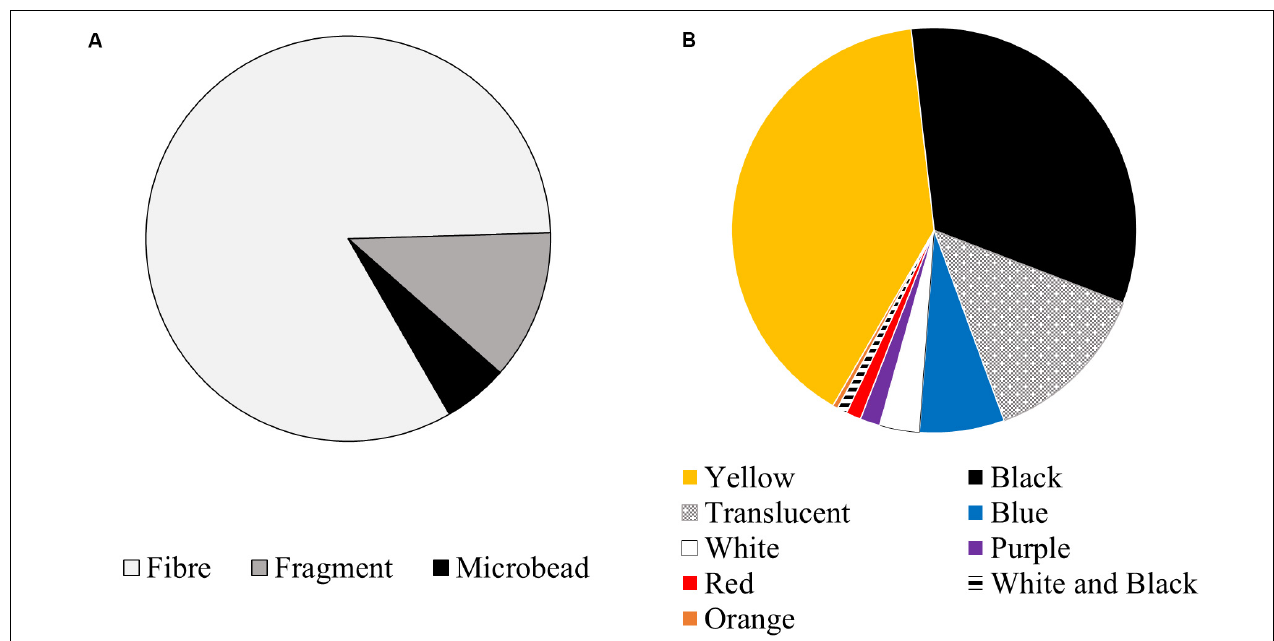
FIGURE 3 | (A) Shape and (B) colour classification of debris recovered from the gastrointestinal tracts of sardines caught in Frenchman Bay, Western Australia in January 2019.